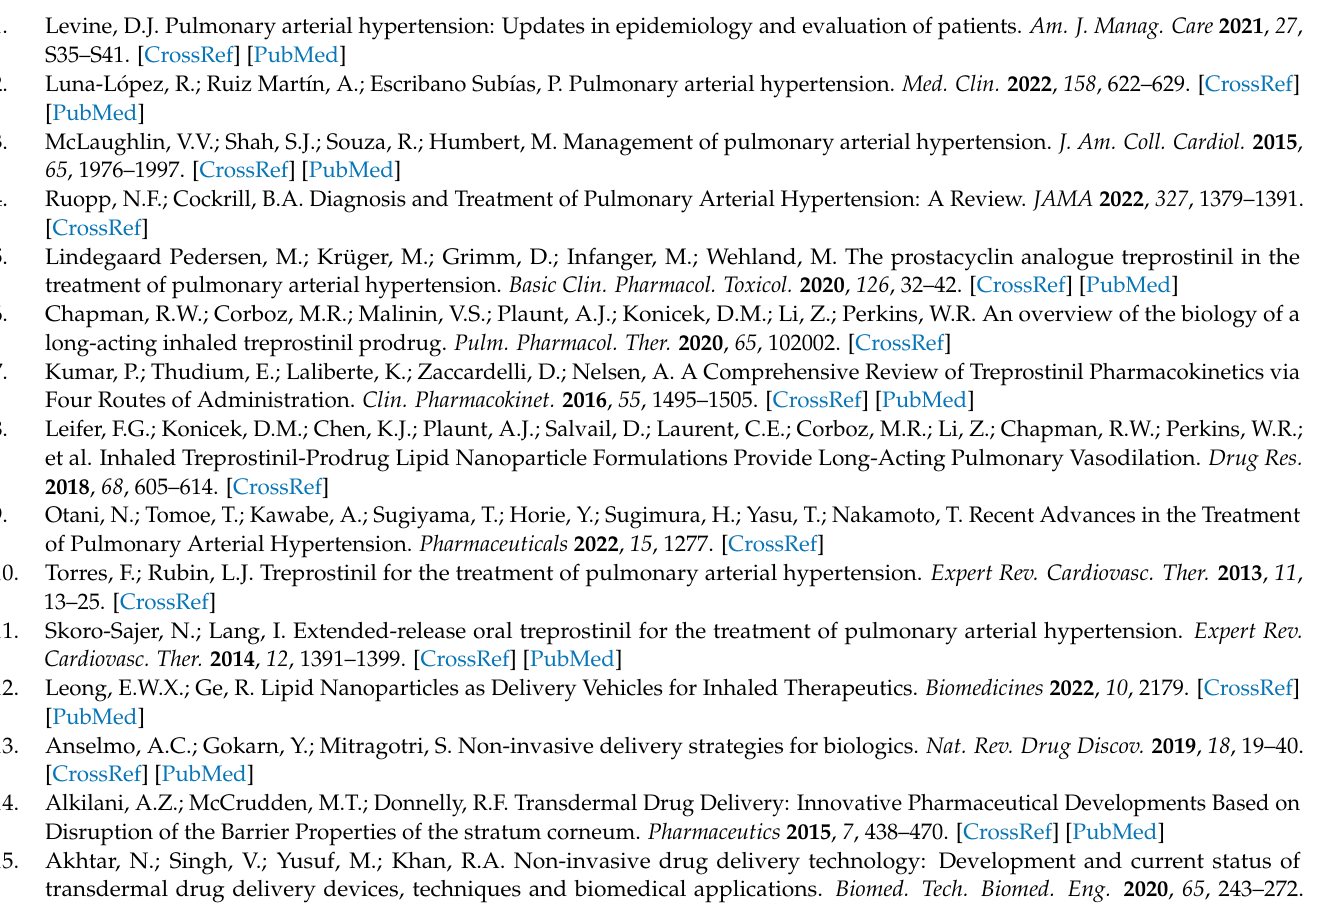
patch; Figure S1. Load versus time curve of the peeling force of optimized patch; Figure S2. Load versus time curve of the tackiness of optimized